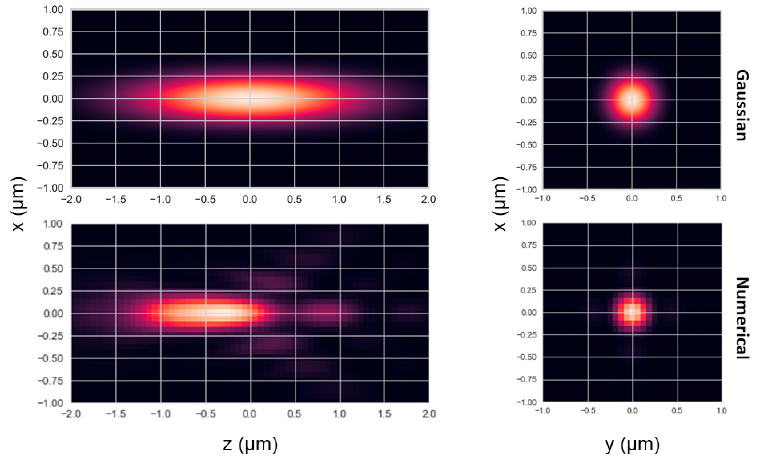
Figure 1. Models of the point-spread function (PSF). The PSF was modeled either as Gaussian-shaped or numerically calculated by using the model of an excitation PSF calculated with PSFLab [15] for a typical 60x water immersion objective with a numerical aperture of 1.2, with a sample mounted on top a 150 μ m coverglass and with sample excitation at a wavelength of 532 nm, where the PSF that was used was the calculated excitation PSF, taken to the power of two. For more information, see Materials and